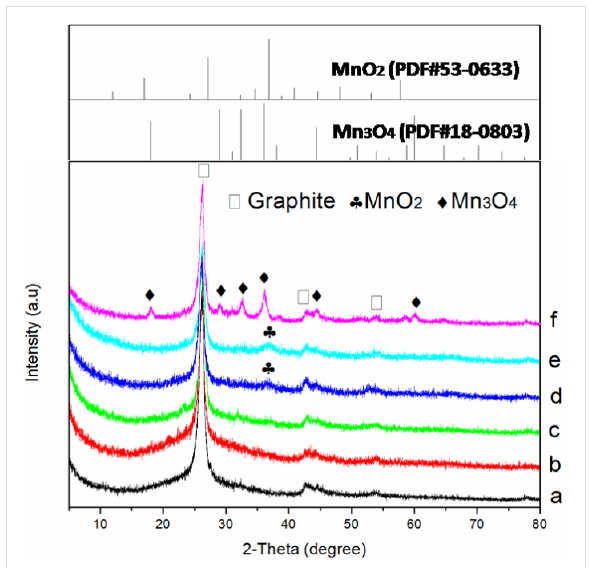
Figure 2: XRD patterns of the acid - treated CNTs and the as - synthe- sized catalysts: (a) acid - treated CNTs, (b) 1% MnO 2 –CuO–Fe 2 O 3 / CNTs, (c) 2% MnO 2 –CuO–Fe 2 O 3 /CNTs, (d) 4% MnO 2 –CuO–Fe 2 O 3 / CNTs, (e) 6% MnO 2 –CuO–Fe 2 O 3 /CNTs, and (f) Mn–Cu–FeO x /CNTs -